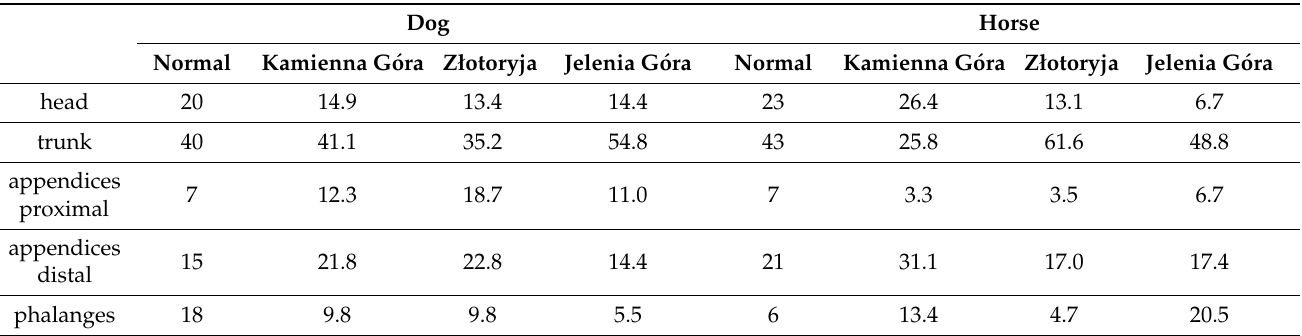
Table 7. Distribution of anatomical parts of horse and dog skeletal remains. Normal, normal anatomical percentage of skeletal